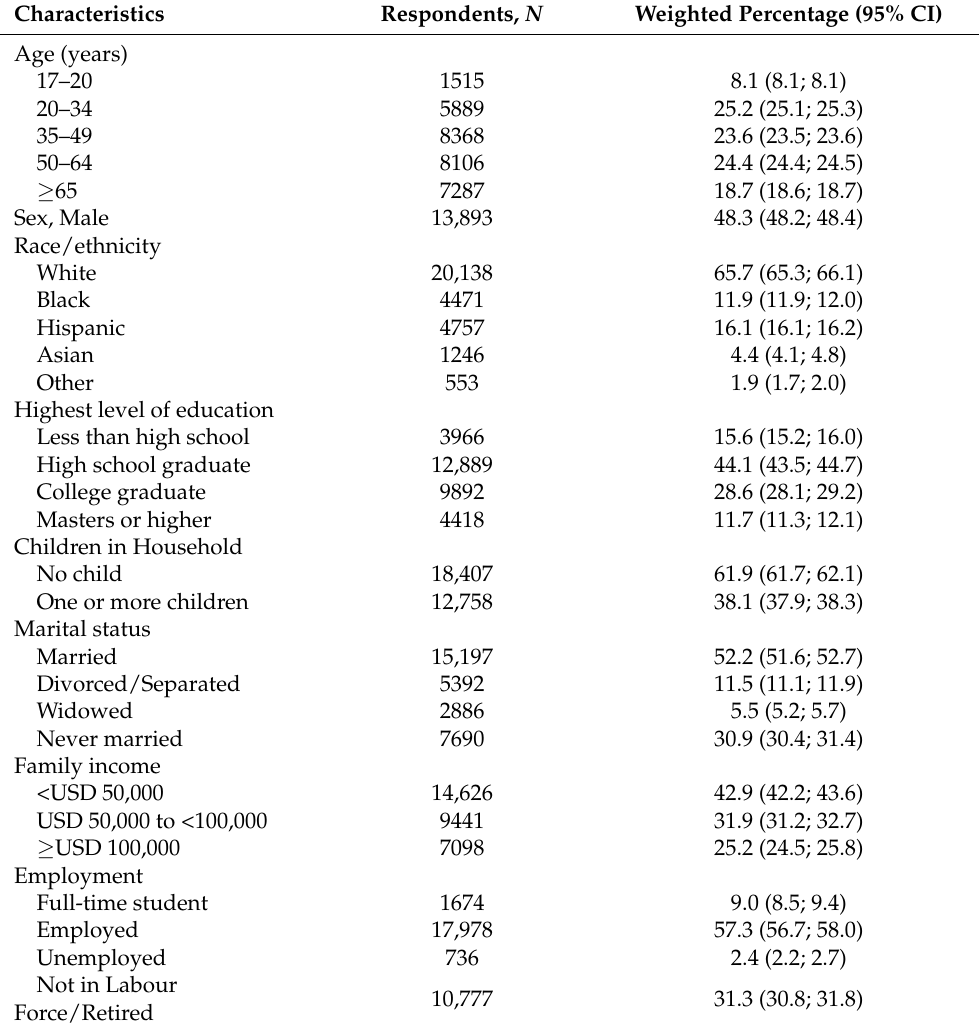
Table 3. Sociodemographic characteristics of ATUS respondents 2015–2017.